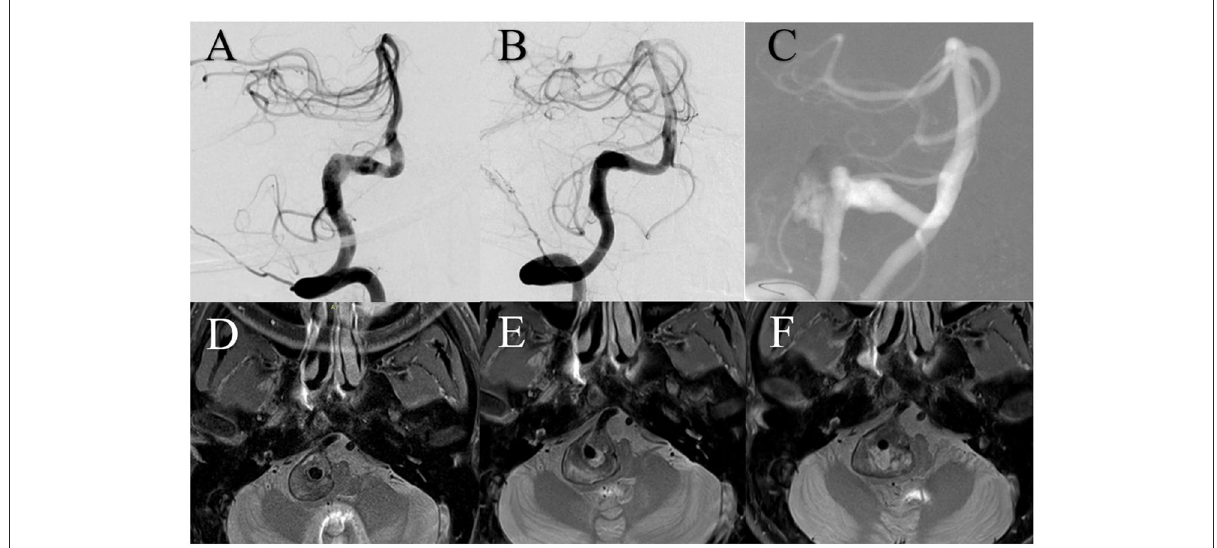
FIGURE3 (A) Digital subtraction angiography (DSA) showed the right vertebral artery aneurysm. (B) DSA immediately after treatment showed satisfactory arterial reconstruction. (C) DSA 2 years after treatment showed aneurysm recurrence. Magnetic resonance imaging demonstrated intramural hematoma growth from before treatment (D) to 1 year (E) and 2 years (F) after.